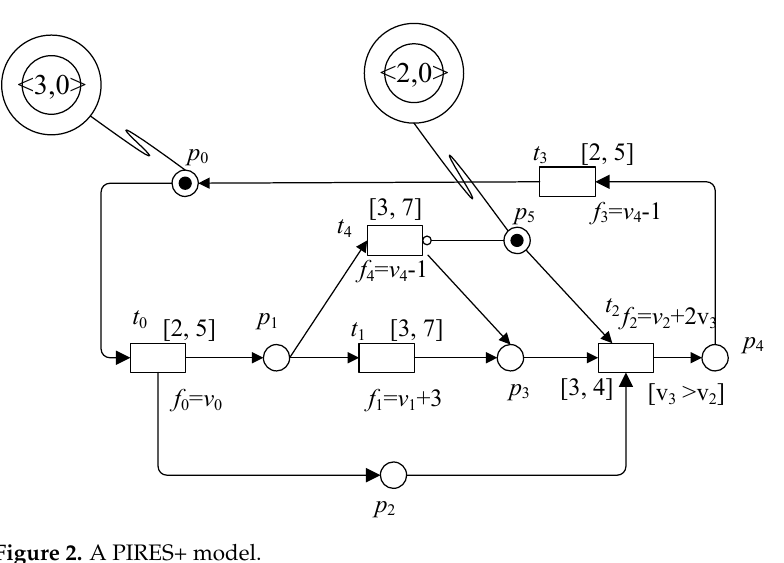
Figure 2. A PIRES+